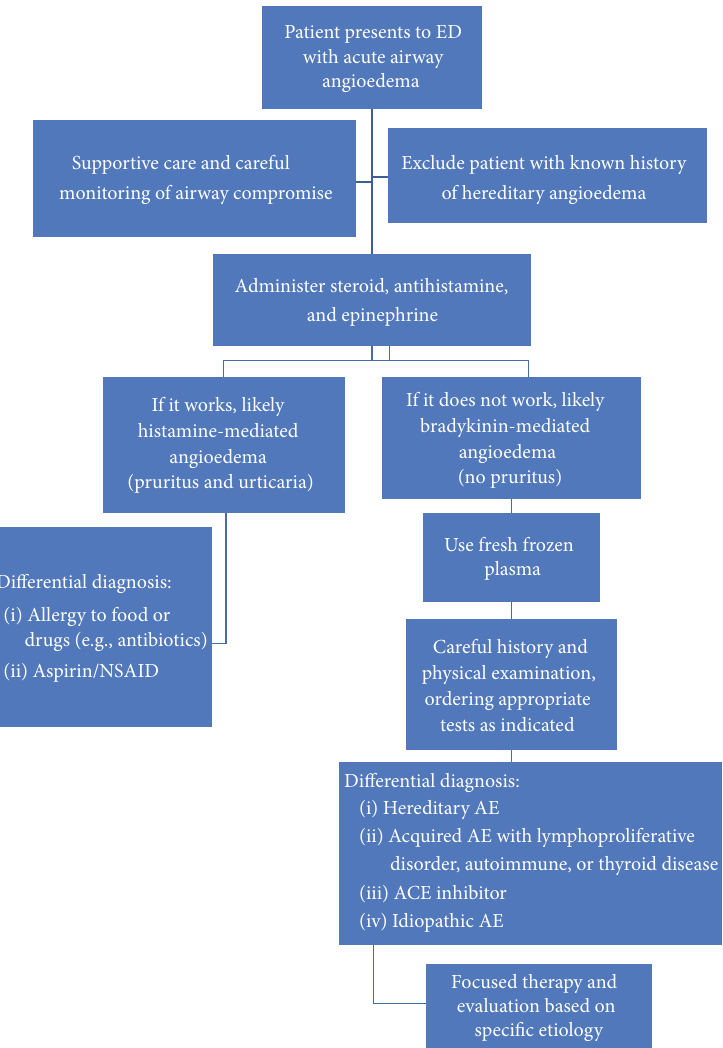
Figure 1: Management